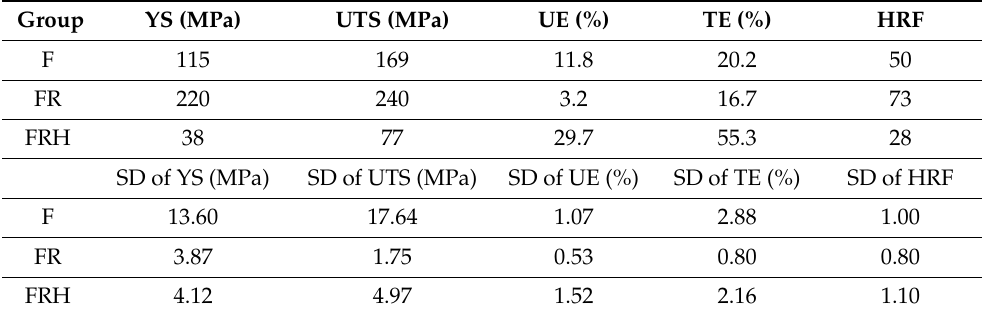
Table 3. Mechanical properties of the Al–Si